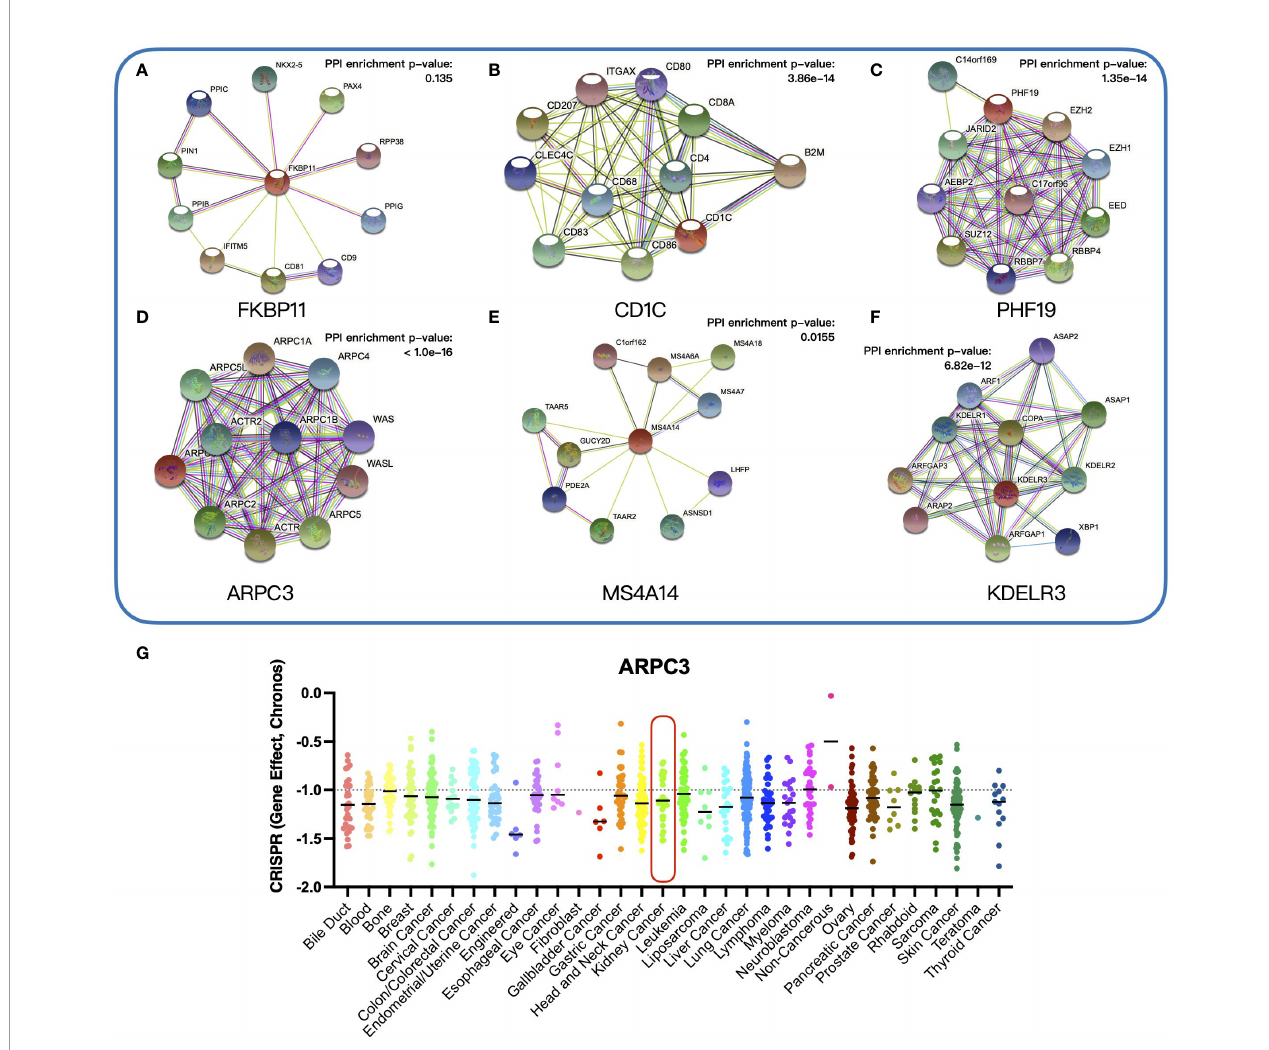
FIGURE 9 | Functional analysis of six key genes. (A – F) Protein – protein interaction networks of six key genes. (G) The Chronos dependency scores of ARPC3 gene in 31 tumor